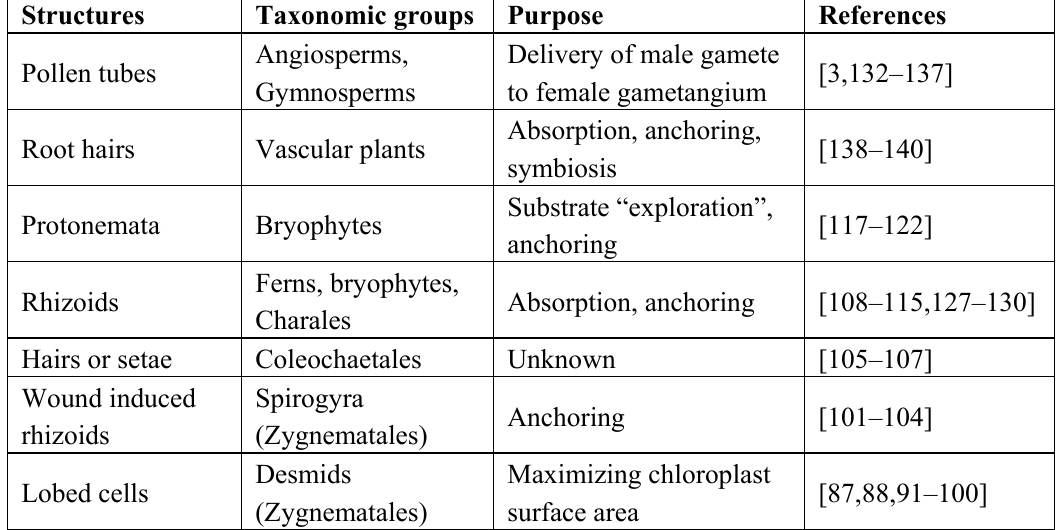
Table 1. Examples of structures that utilize polar growth mechanisms in